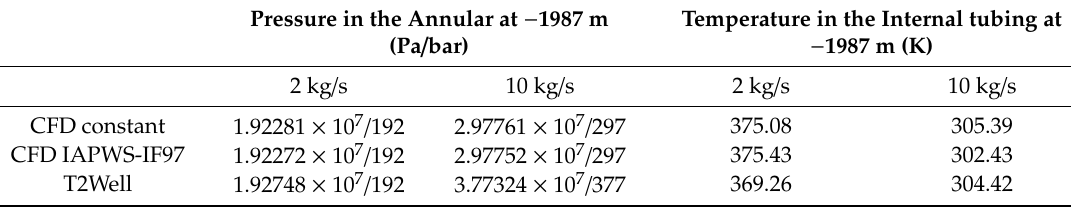
Table 5. Pressure and temperature in DBHE at − 1987 m based on the CFD and T2Well results.